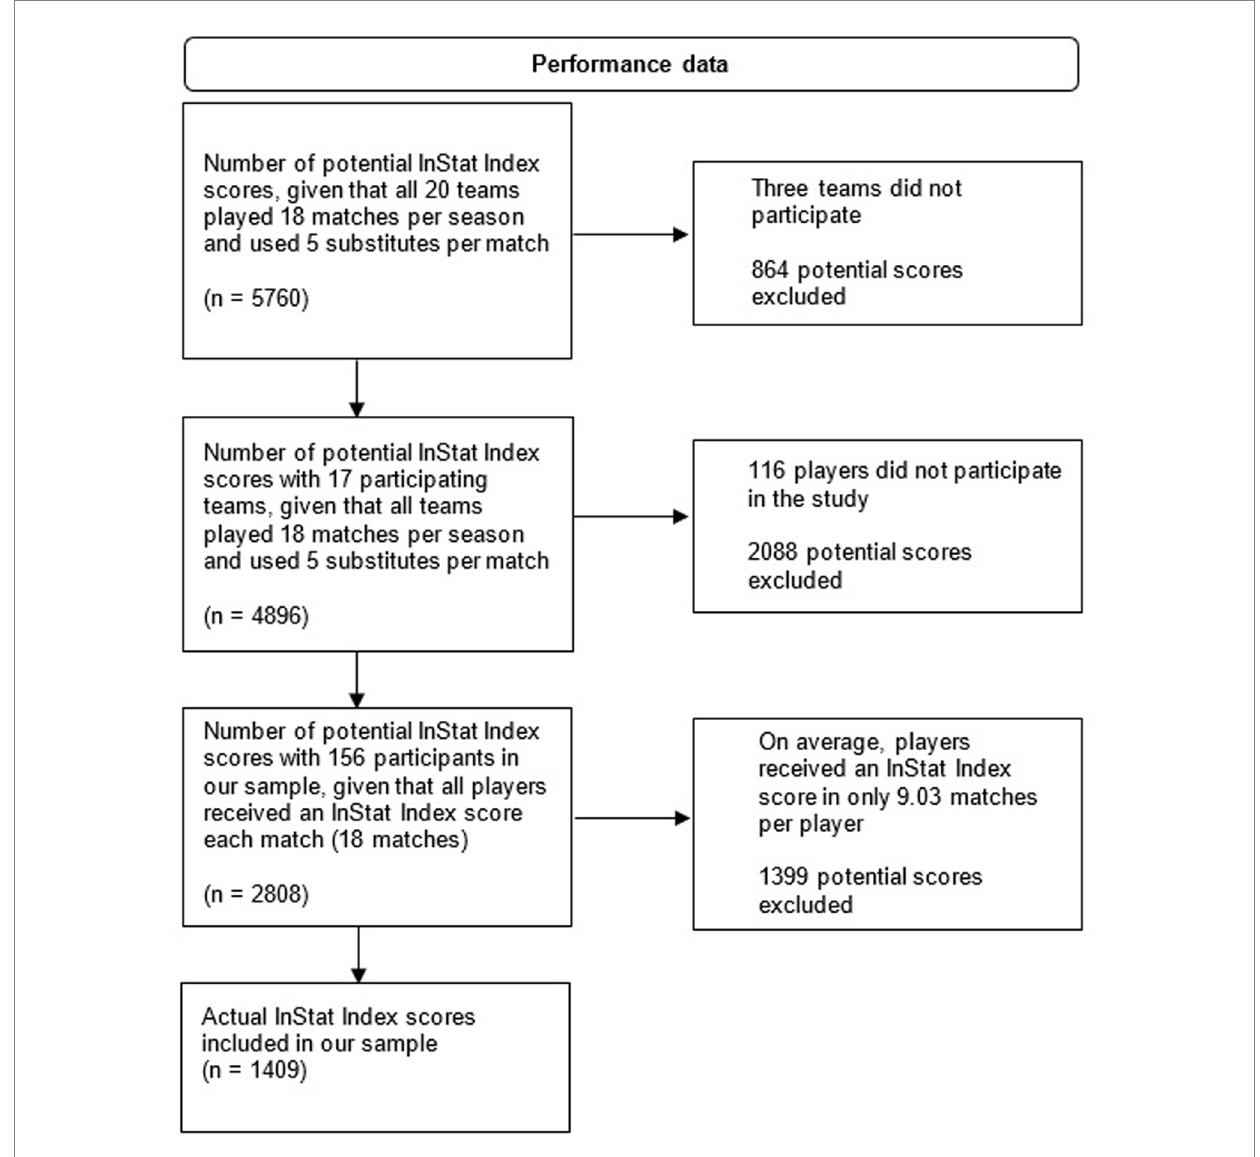
FIGURE 1 Flow diagram of InStat Index